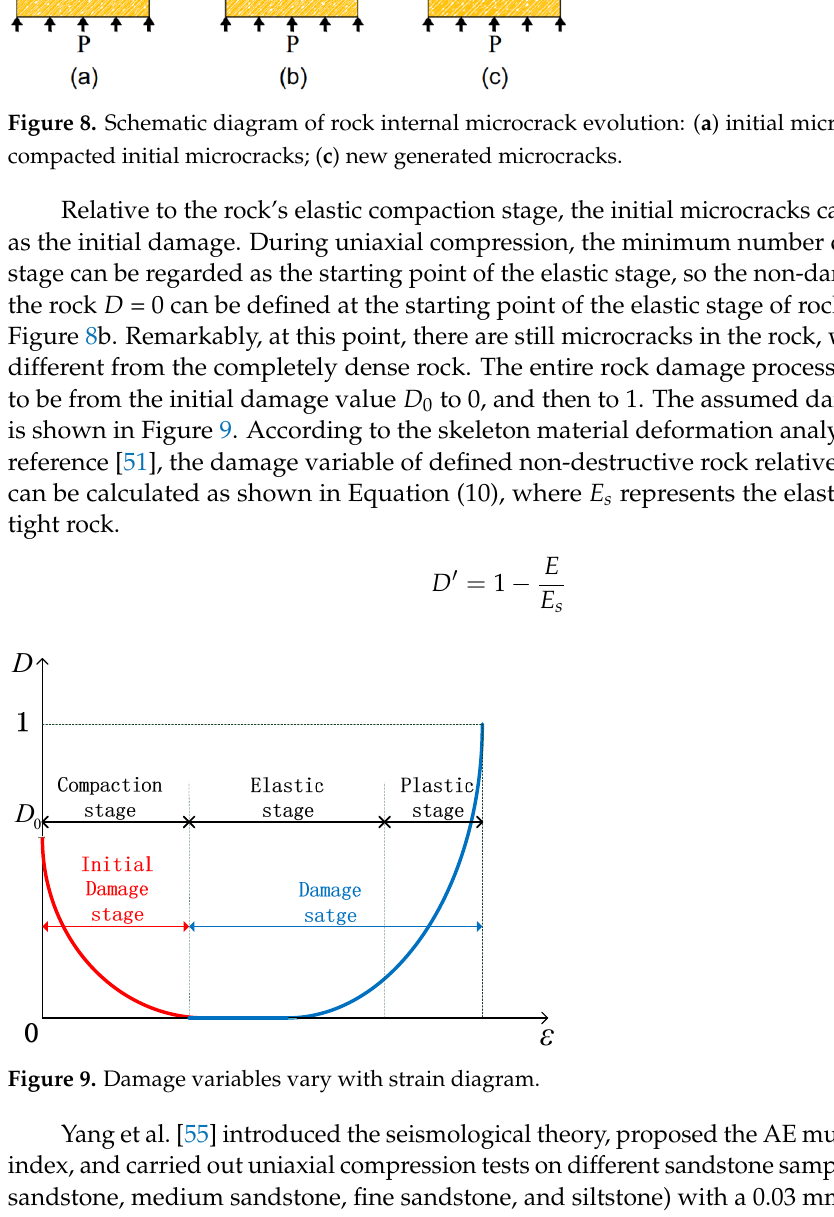
σ Figure 1 0 . Diagram of axes change. 0 0 σ D E ε   (11) Using Equation (11), the initial damage 0 D , under different loading rates, is shown in Table 1.